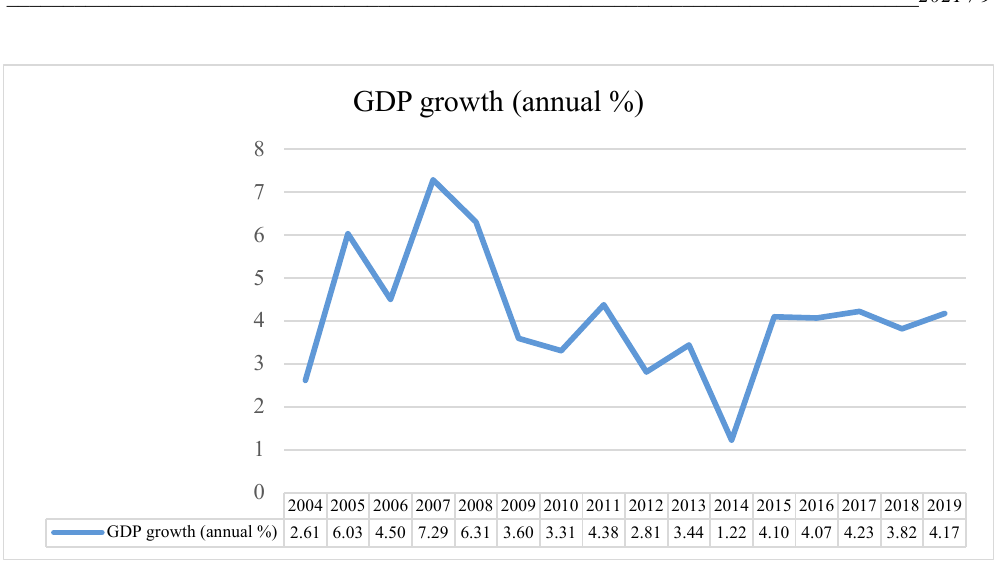
Fig. 1 . GDP trends in case of Kosovo (2004–2019). Figure 1 source: World Bank indicators (World Bank, 2020), GDP growth for Kosovo, time period 2004–2019, the authors’ calculations.